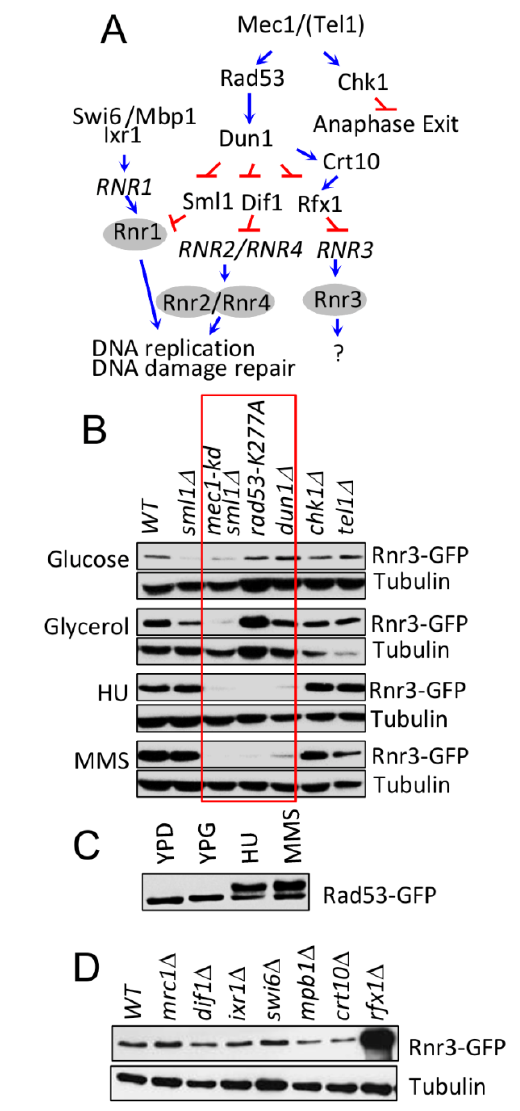
FIGURE 3: Mec1 mediates the carbon source dependent induction of Rnr3 independently of its DNA damage re- sponse network. (A) Key components of the Mec1 checkpoint response network involved in RNR regulation [19]. Blue ar- rows and red bars denote a positive and inhibitory impact on the indicated gene or protein. (B) Strains of the indicated genotypes (Table S1) were cultured in YPD, YPG, and YPD supplemented with HU (10 mM) or MMS (0.01%). WCE sam- ples were prepared from cells in log phase (YPD and YPG) or following 2 hours exposure to HU or MMS and subjected to Western blot analysis using -GFP antibodies. Tubulin was used as a loading control. Red box: Mutations that abolish the DDR dependent Rnr3 induction. (C) RAD53-GFP cells were cultured in YPD, YPG, and YPD supplemented with HU (10 mM) or MMS (0.01%). WCE samples were prepared from cells in log phase (YPD and YPG) or following 2 hours exposure to HU or MMS and subjected to Western blot analysis using - GFP antibodies. (D) WCE samples prepared from the indicat- ed strains (Table S1) grown to mid-log phase in YPG were subjected to Western blot analysis using -GFP antibodies. Tubulin was used as a loading